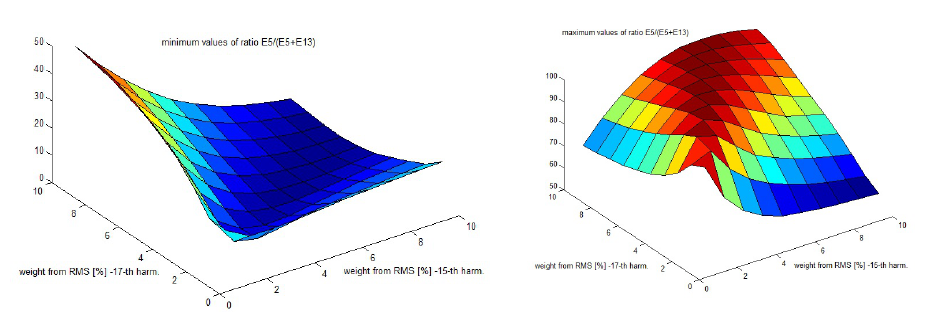
Figure 1. Minimum values of the ratio between the energy of the 5-th node and the sum between the en- ergies of the 5-th and 13-th nodes when the 15-th and 17-th harmonics act jointly in a T7 topology.